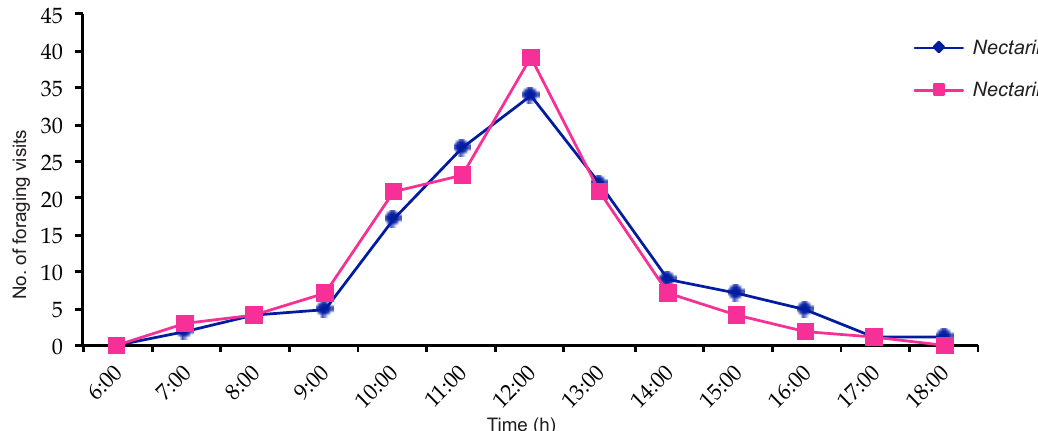
Figure 4. Hourly foraging activity of butterfly on Boswellia ovalifoliolata Figure 4: Hourly foraging activity of butterflies on Boswellia ovalifoliolata Figure 4: Hourly foraging activity of butterflies on Boswellia ovalifoliolata